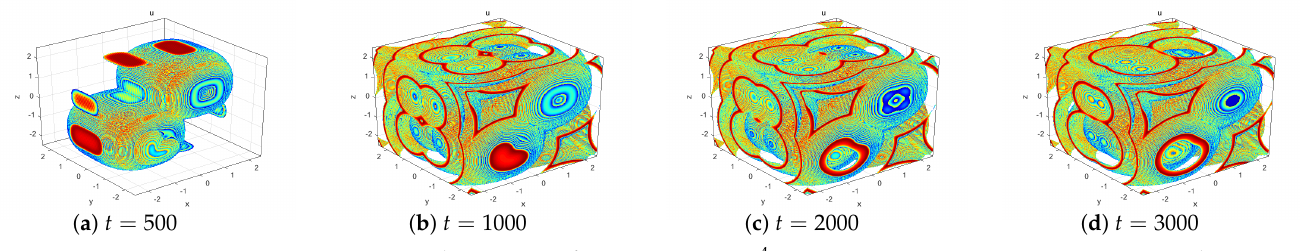
Figure 11. The patterns of u at K u = 1 × 10 − 4 , ε = 0.0001, µ = 0.01, β = 0.5, N = 512, and α = 2.